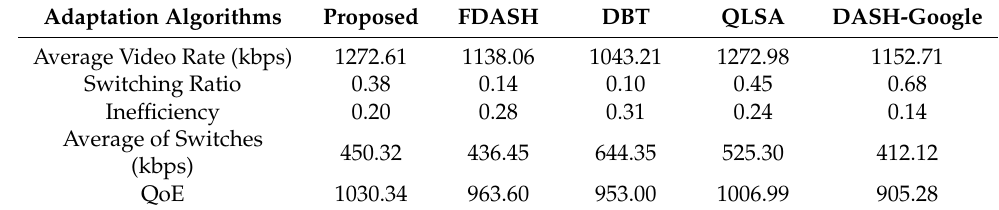
Table 8. Performance of the algorithms at a buffer size of 60 s and a segment duration of 4 s.